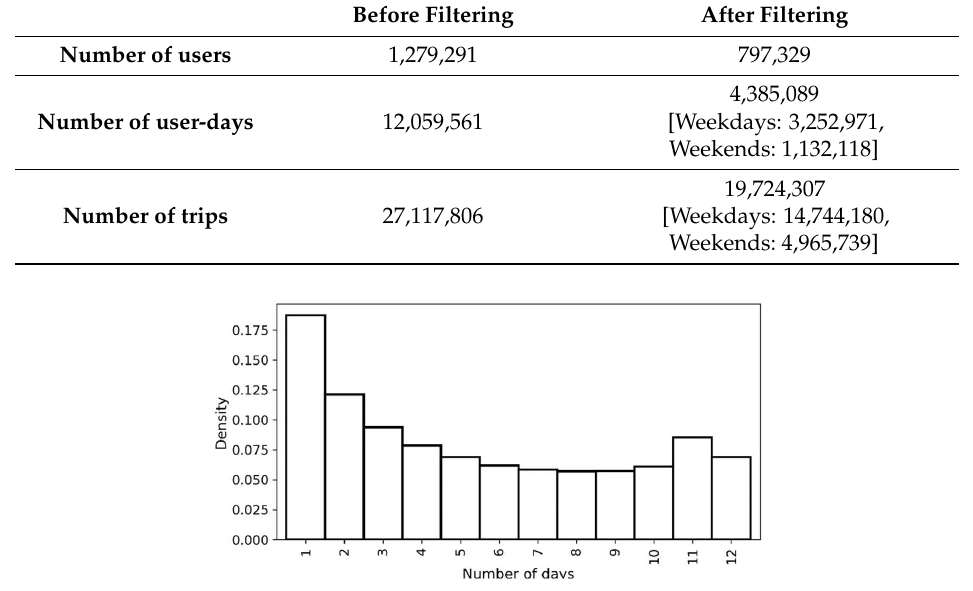
Table 4. Statistical summary of user sample before and after filtering valid user-days.